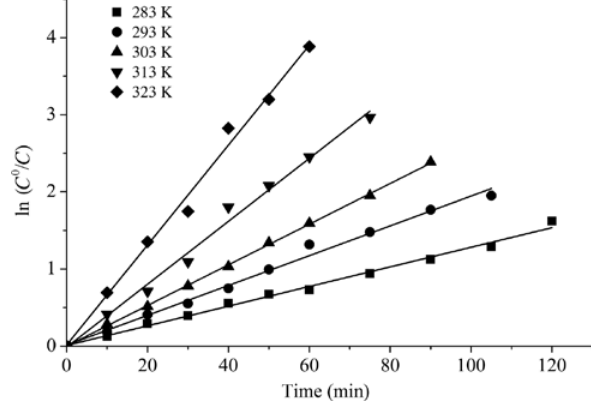
Figure 11: First-order kinetic studies of the catalytic oxidation of DBT at different temperatures.